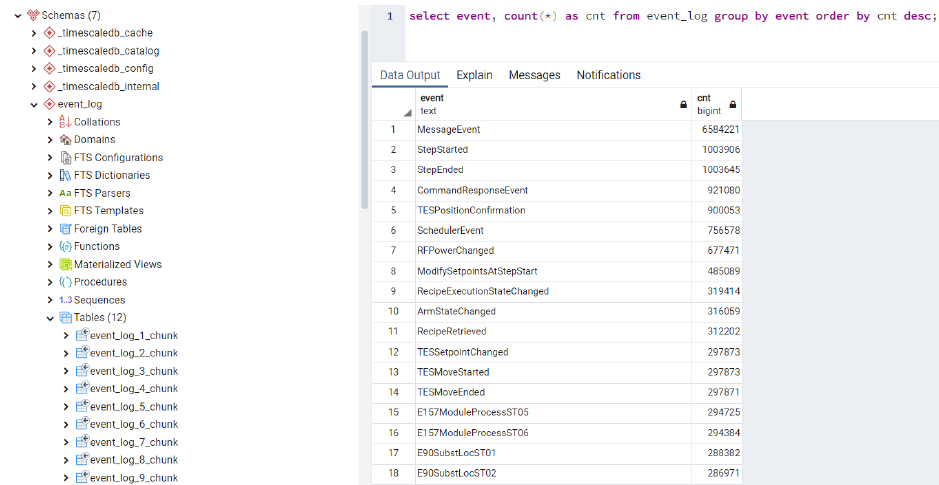
Figure 3. Hypertable (Logical database